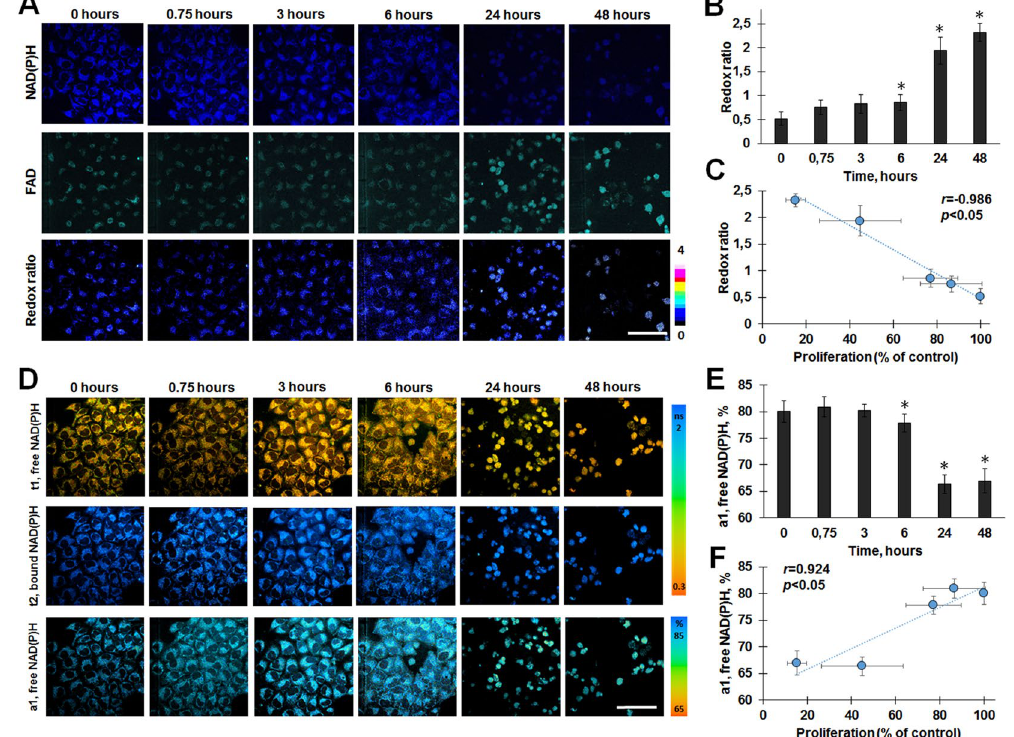
Figure 3. The optical redox ratio FAD/NAD(P)H and FLIM of NAD(P)H in surviving HeLa cells during cisplatin exposure. ( A ) The fluorescence images of NAD(P)H and FAD and the optical redox ratio images. ( B ) Quantification of the redox ratio, mean ± SD, n = 50. ( C ) Pearson’s correlation between the redox ratio and cell proliferation. ( D ) Pseudocolor-coded images of the free (t1, ns) and protein-bound (t2, ns) forms of NAD(P)H and the relative amplitude (a1, %) of free NAD(P)H. ( E ) Dynamics of the fluorescence lifetime amplitude of free